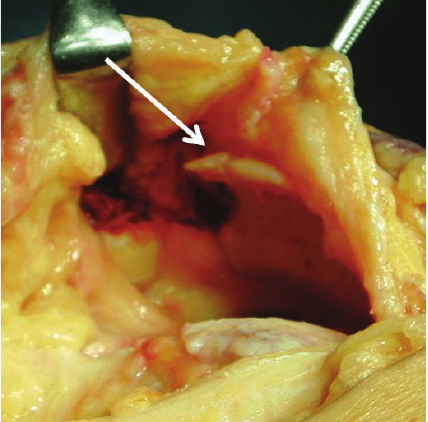
Figure 2: Intraoperative findings. Osteophyte is apparent on the superior pole of the patella